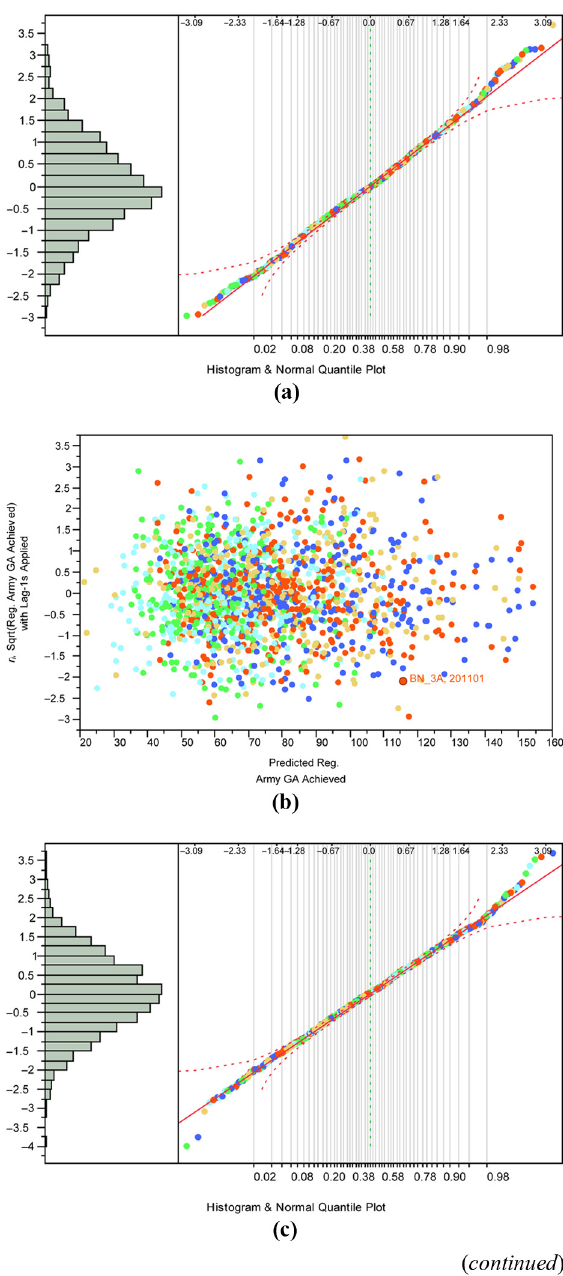
Figure 2. Left side are quantile plots showing general acceptance of normality assumption. Right side are plots indicating no issues with the constant variance